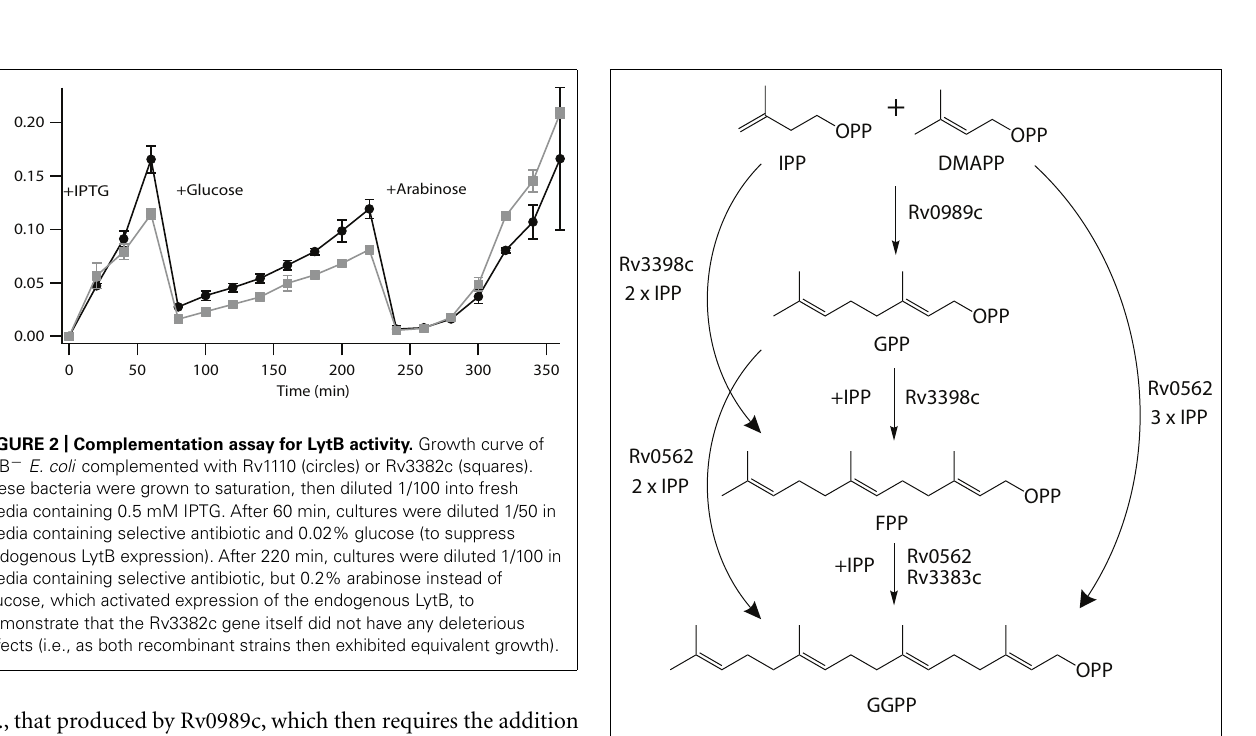
FIGURE 3 | Substrate plasticity of GGPPS. GGPPS enzymes are sometimes able to utilize a variety of substrates to synthesize the 20-carbon product, GGPP. Outlined are the various biosynthetic pathways for GGPP production in Mtb .